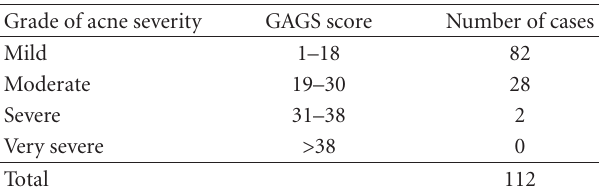
Table 1: GAGS (global acne grading system) score distribution. Grade of acne severity GAGS score Number of